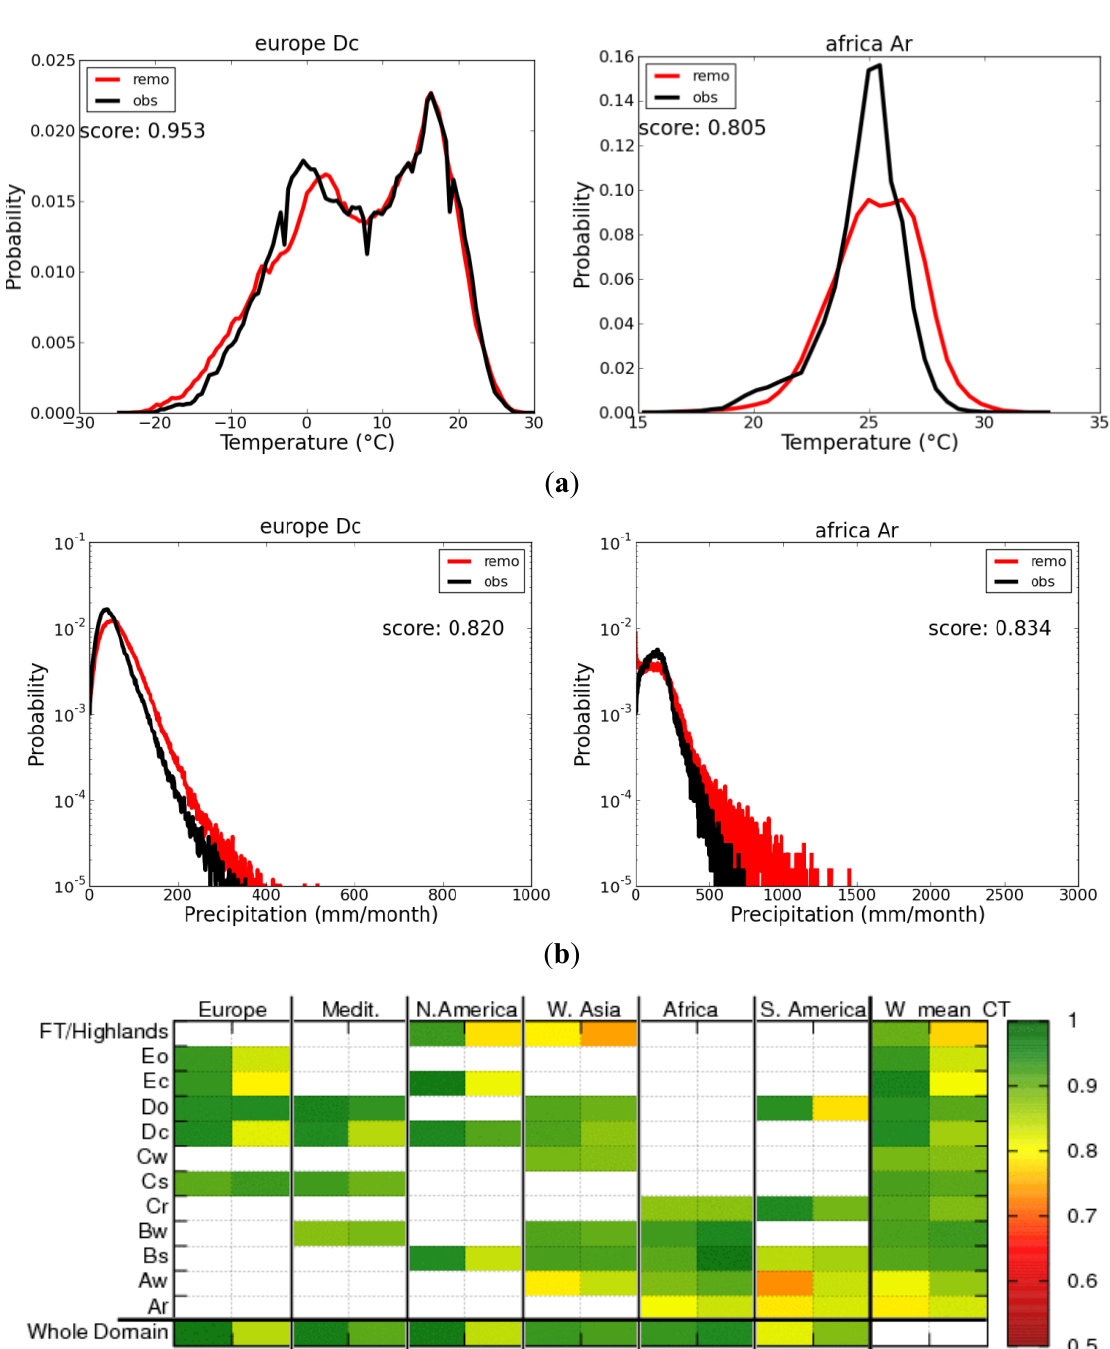
Figure 6. Probability density function (PDF) Skill scores for ( a ) temperature (T) and ( b ) precipitation (P). Example PDF results in selected regions: temperate continental climate (Dc) over Europe (a and b, left); and tropical humid climate (Ar) over Africa (a and b, right). The temperature and precipitation PDF curves for the observed (black) and simulated (red) distributions are shown. The precipitation plots are in logarithmic scale and the probability values shown are equal or greater than 10 − 5 . ( c ) Summary of the PDF skill scores for all climate types. The last column shows the weighted mean of PDF skill scores (W_mean_CT) across different domains for every climate type. The period considered is 1989 to